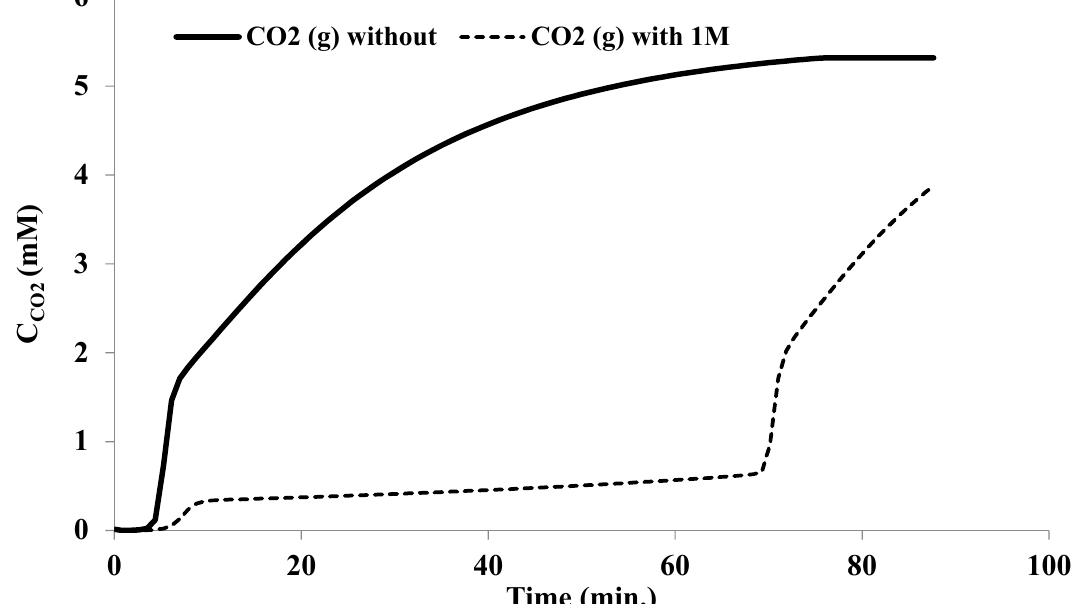
Figure 2. Time variation of CO 2 concentration in gas phase measured at exit stream with and without GBIG. Kasturi et al. [17,22] reported that the values of the concentration of the different amino acid forms, the concentration of the products of the different reactions with CO 2 , and the pH are strongly related. The simulation results are shown in Figures 3–5.